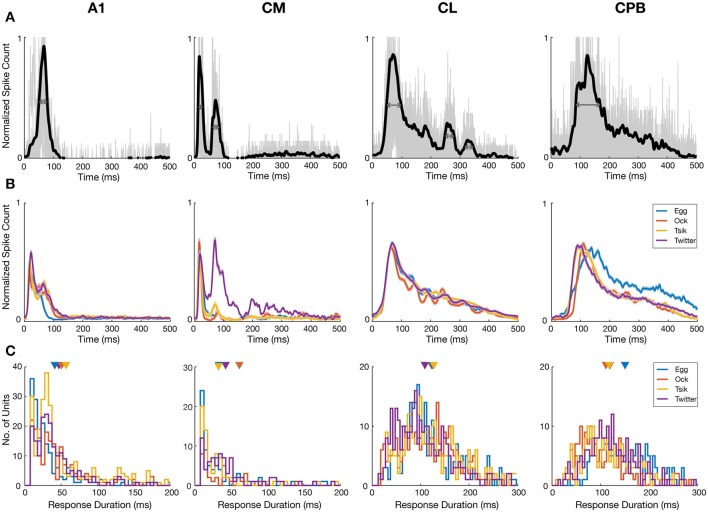
Response temporal patterns and distributions of response duration. (A) Example normalized mean PSTHs across pitch tokens and individual responses to different pitch tokens of a given call. Black curve indicates the normalized mean response of a unit in each cortical area. Gray curves indicate the responses to each pitch tokens of a given call. Dark gray arrows indicate the half-peak width of the response which is termed as the response duration of the unit to that call. (B) Mean normalized PSTHs for different calls in the different auditory cortical areas A1, CM, CL, and CPB. Each cell's responses are pooled from different pitch tokens of each call, to generate a single normalized PSTH for each unit for each call and then averaging the normalized PSTH for that call across all units in that cortical area to yield a single mean PSTH for that call. Shading indicates standard error of the mean response. Different color indicate response to different calls. Note that in A1 and CM response peaks occurred early, and responses were generally short lasting and complete within ≈100 ms from stimulus onset, whereas in CL and CPB response peaks occurred much later and responses were much longer-lasting, up to 500 ms post-stimulus onset. (C) Distributions of response duration, calculated as the half-peak width of the PSTH, of individual units to different calls. Color indicates different call and triangle indicates the mean of the distribution.